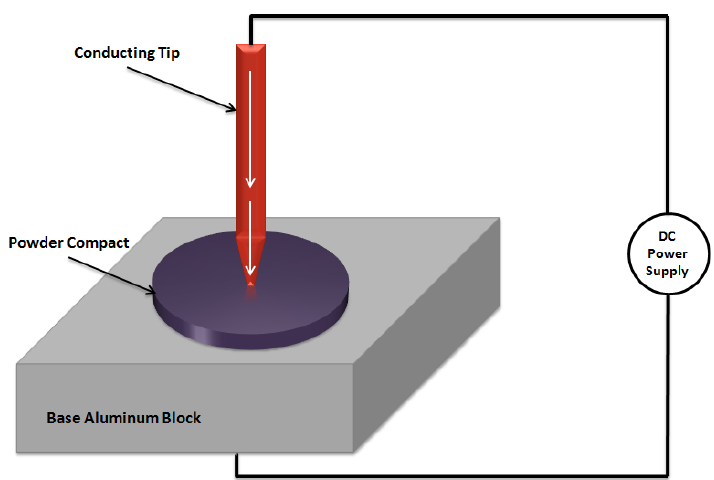
Figure 1. Schematic of a CATS